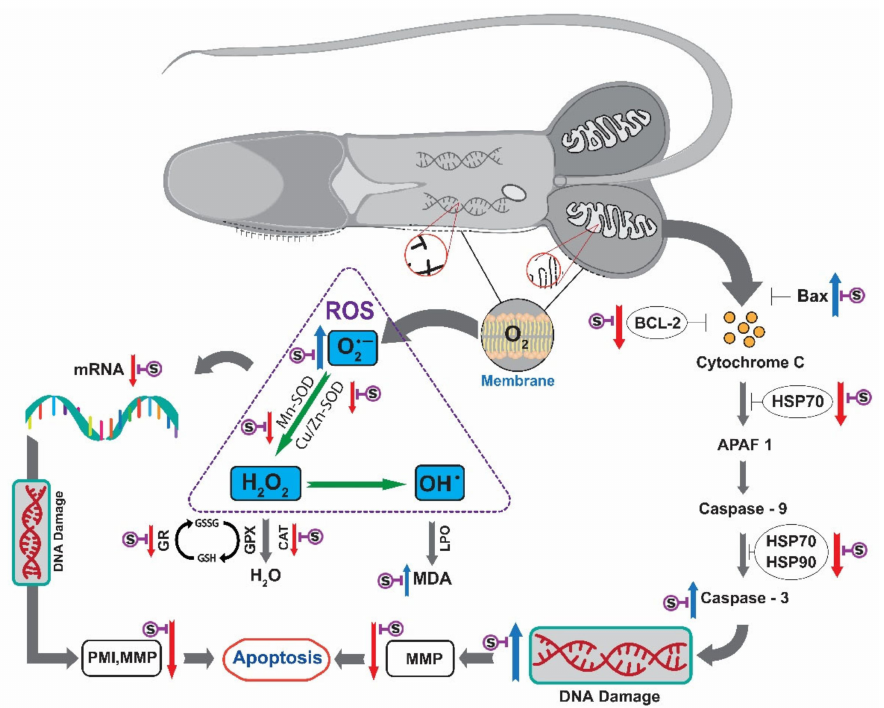
Figure 11. Oxidative stress-oriented apoptosis pathway of cryopreserved sperm of Pacific abalone, H. discus hannai and influence of saccharides in the pathway. Cryopreserved sperm showed higher mRNA expression of Bax (apoptosis gene) but lower mRNA expression of BCL-2 (anti-apoptosis gene). Higher mRNA expression of Caspase-3 was found when HSP70 and HSP90 showed lower mRNA expression. Such molecular alterations led to sperm DNA damage by reducing MMP, finally leading to apoptosis. Freeze–thaw process of cryopreservation disrupted the plasma membrane of sperm that produced O 2 from interspace of membrane and converted to O 2 •− . Cryopreserved sperm showed higher production of O 2 •− and MDA when antioxidant enzyme (CAT, SOD, and GSH) showed lower activities and five vital antioxidant genes (CAT, Cu/Zn-SOD, Mn-SOD, GPx, and GR) showed reduced mRNA expression. This disruption of oxidative defense damaged DNA, PMI and MMP, finally leading to apoptosis. However, saccharide supplemented cryopreserved sperm showed improvement against all parameters of apoptosis. The influence of saccharide is marked using a symbol, in the apoptosis pathway where appropriate.